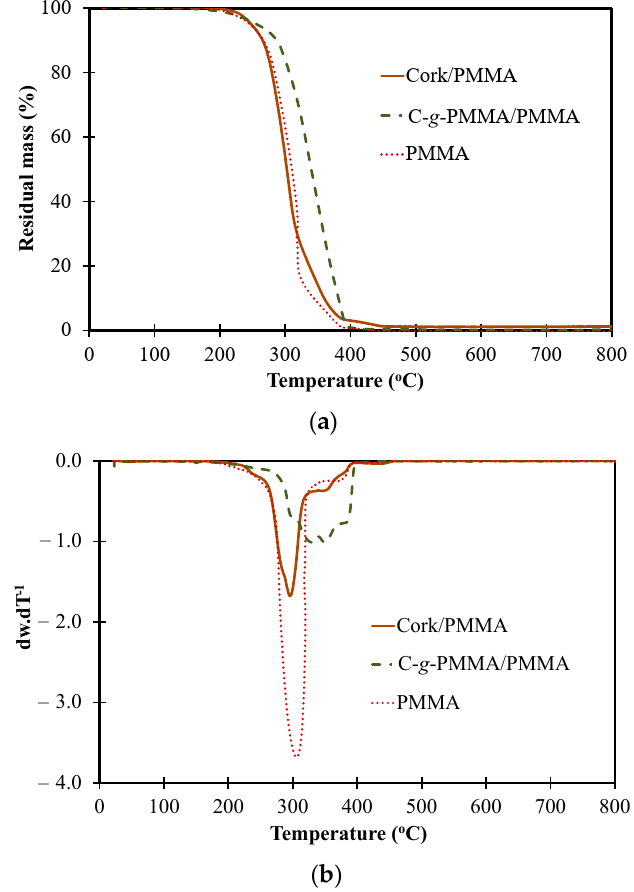
Figure 7. Thermal analyses: thermogram ( a , b ) first derivative of weight loss as a function of the temperature of Cork/PMMA, C- g -PMMA/PMMA and PMMA.